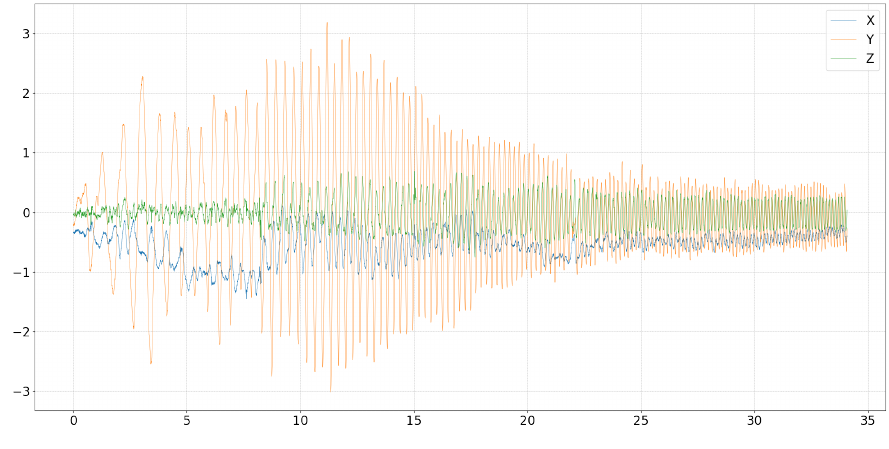
Figure 3. Sensor data: linear acceleration time series.